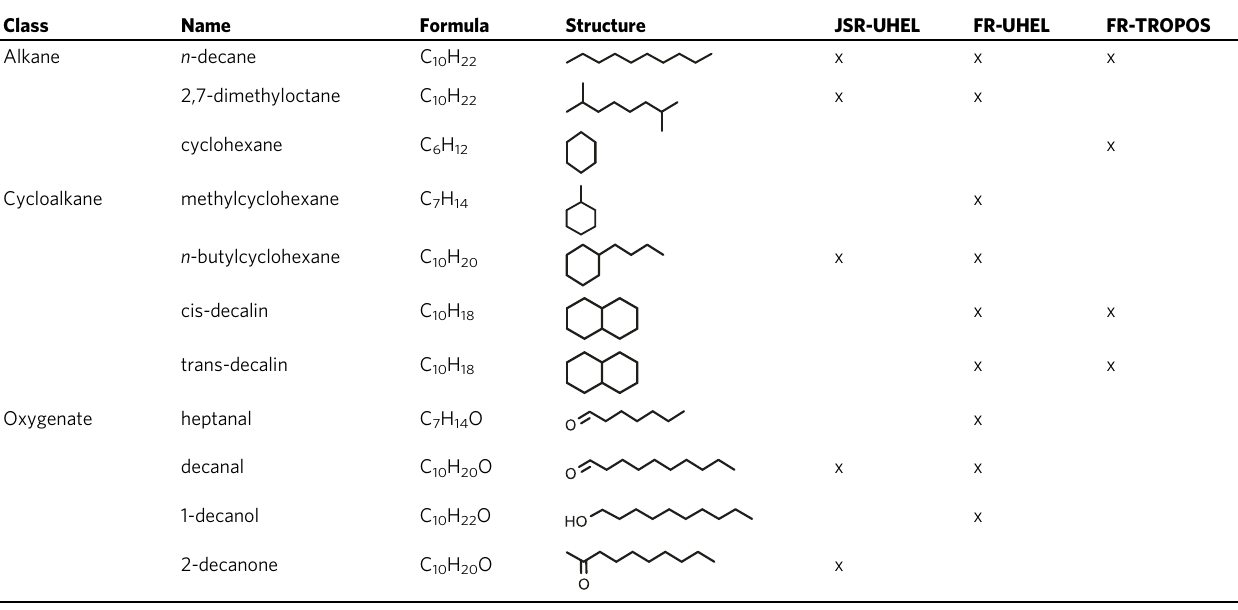
The last three columns refer to the three different types of experiment conducted. Note: JSR-UHEL: jet-stirred reactor experiments at University of Helsinki; FR-UHEL: fl ow reactor experiments at University of Helsinki; FR-TROPOS: fl ow reactor experiment at Leibniz Institute for Tropospheric